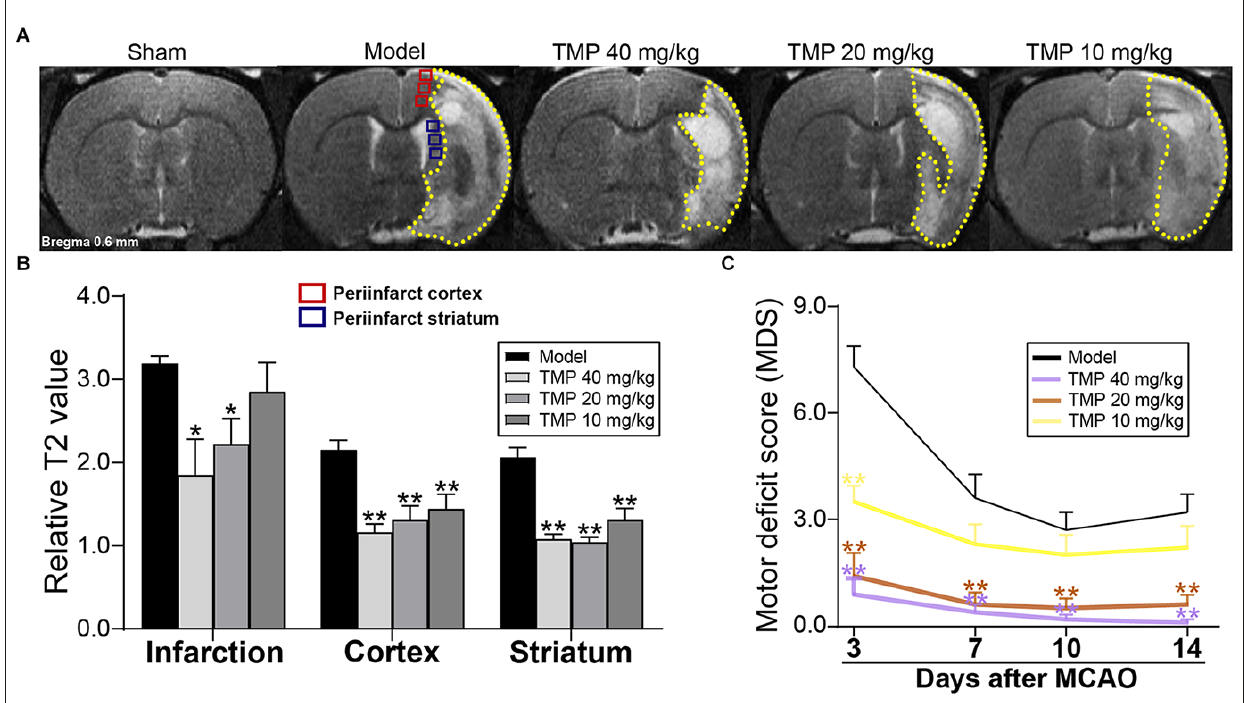
FIGURE1 TMP improved tissue injury and neurological function of MCAO rats. (A) Typical T2 relaxometry maps showed the tissue injury of rats ( n = 6). Quantitative analysis of (B) relative T2 value (rT2) of infarction (yellow dotted lines), periinfarct cortex (red box), and striatum (blue box) at the 14th day after MCAO, and (C) motor deficit score (MDS) at the 3rd, 7th, 10th, and 14th day after MCAO ( n = 10). * P < 0.05, ** P < 0.01 vs. Model group.